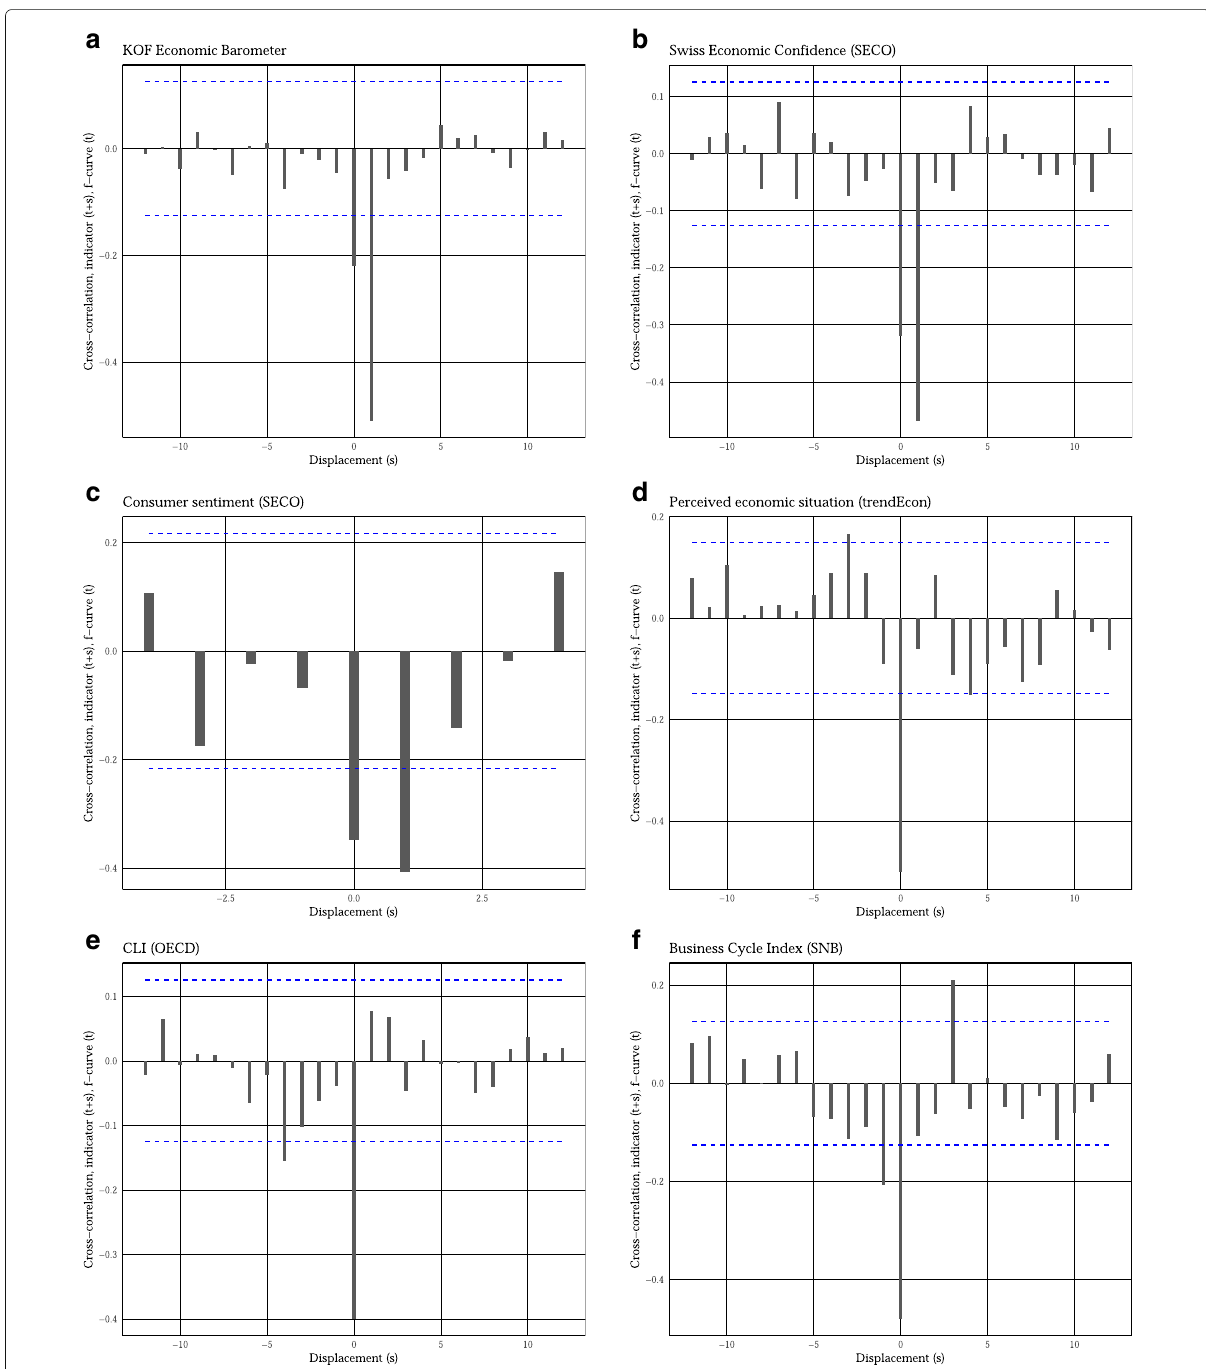
Fig. 2 Cross-correlation with other indicators. Cross-correlation between the f -curve and other prominent leading and sentiment indicators. We aggregate all data either to quarterly frequency (consumer sentiment) or monthly frequency (remaining indicators). The dashed lines give 95% confidence intervals. A bar outside of the interval suggests a statistically significant correlation between the indicators at a lead/lag of s . Before computing the cross-correlation, the series have been pre-whitened with an AR(p) model (see Neusser 2016, Ch. 12.1). The lag order has been determined using the Bayesian information criterion. The only exception is the OECD CLI for which we used an AR(4)